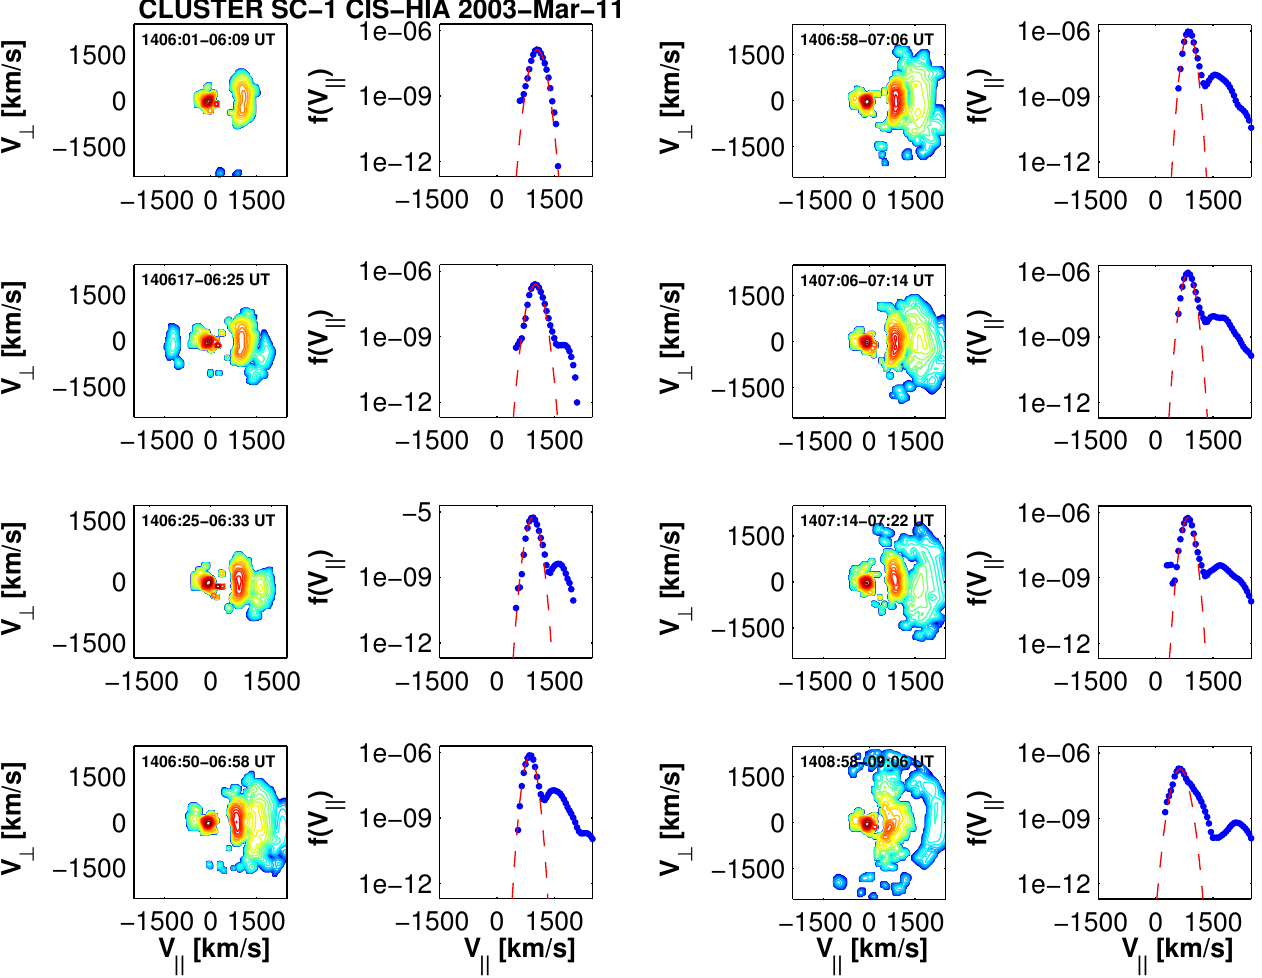
Fig. 2. Successive left panels show the ion velocity distribution in the v k - v ⊥ system of coordinates and in the plasma frame of reference; the contours at the origin are associated with the solar wind measurement. Successive right columns show the corresponding reduced parallel distribution functions f ( v k ); the solar wind has been removed. The dashed red line represents the best Gaussian fit of the FAB distribution component. The contour levels of the space phase density are coded such that the deep red corresponds to 10 − 6 cm − 3 /(kms − 1 ) 3 and the purple to 10 − 14 cm − 3 /(kms − 1 ) 3